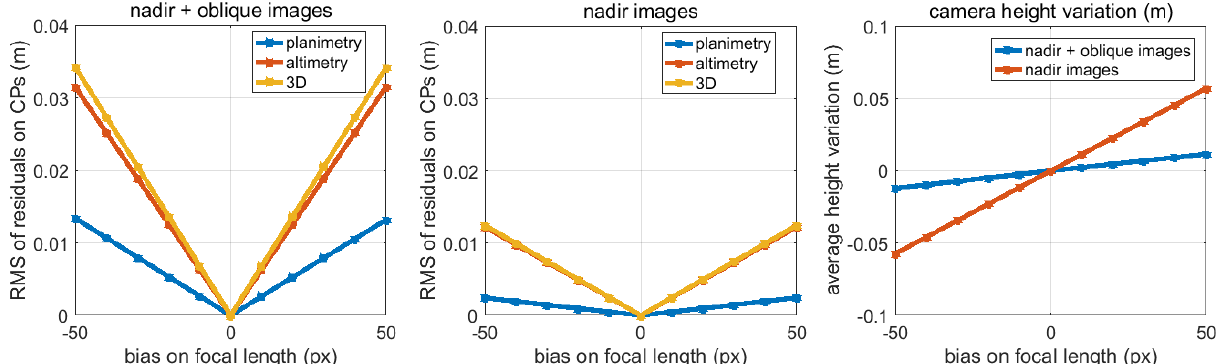
Figure 4. Variation of residuals on CPs and camera height with error on the focal length. Left : variation of residuals on CPs with error on focal length when all images (flight 1-4) are introduced to bundle block adjustment. Middle : variation of residuals on CPs with error on focal length when only nadir images (flight 1-3) are introduced to bundle block adjustment. Right : variation of average camera height with error on focal length.